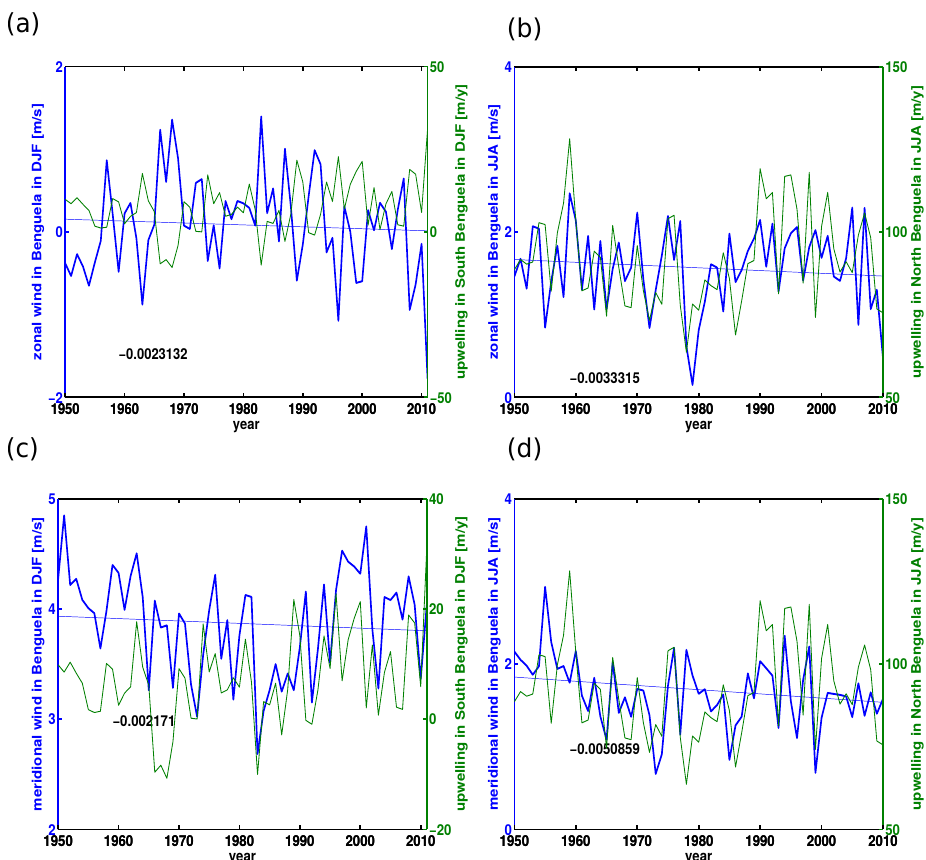
Figure 5. Time series of wind components in DJF (a, c) and JJA (b, d) of NCEP/NCAR reanalysis over Benguela in the period 1948–2011.